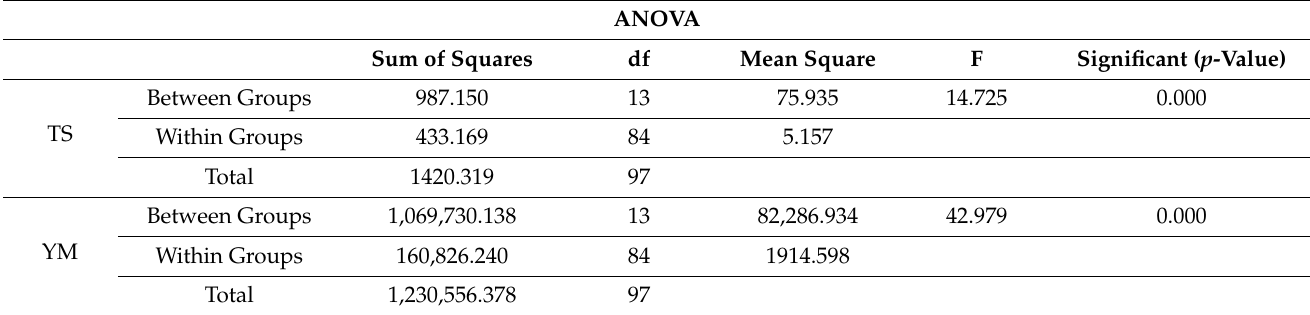
Figure 10. Boxplot for the selected responses using 14 different compositions. Table 7. The results of ANOVA for the selected